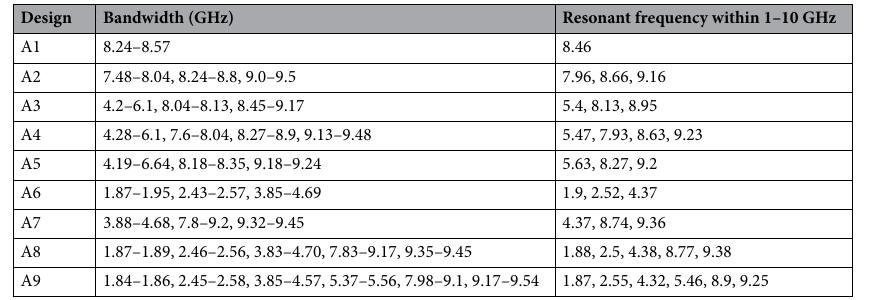
Table 2. Data specification for the different unit cell